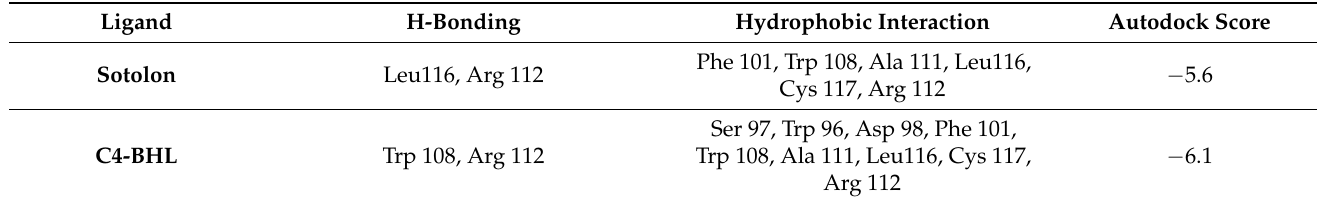
Table 2. The binding mode of each ligand with the different residues inside the active site of rhlR. Ligand